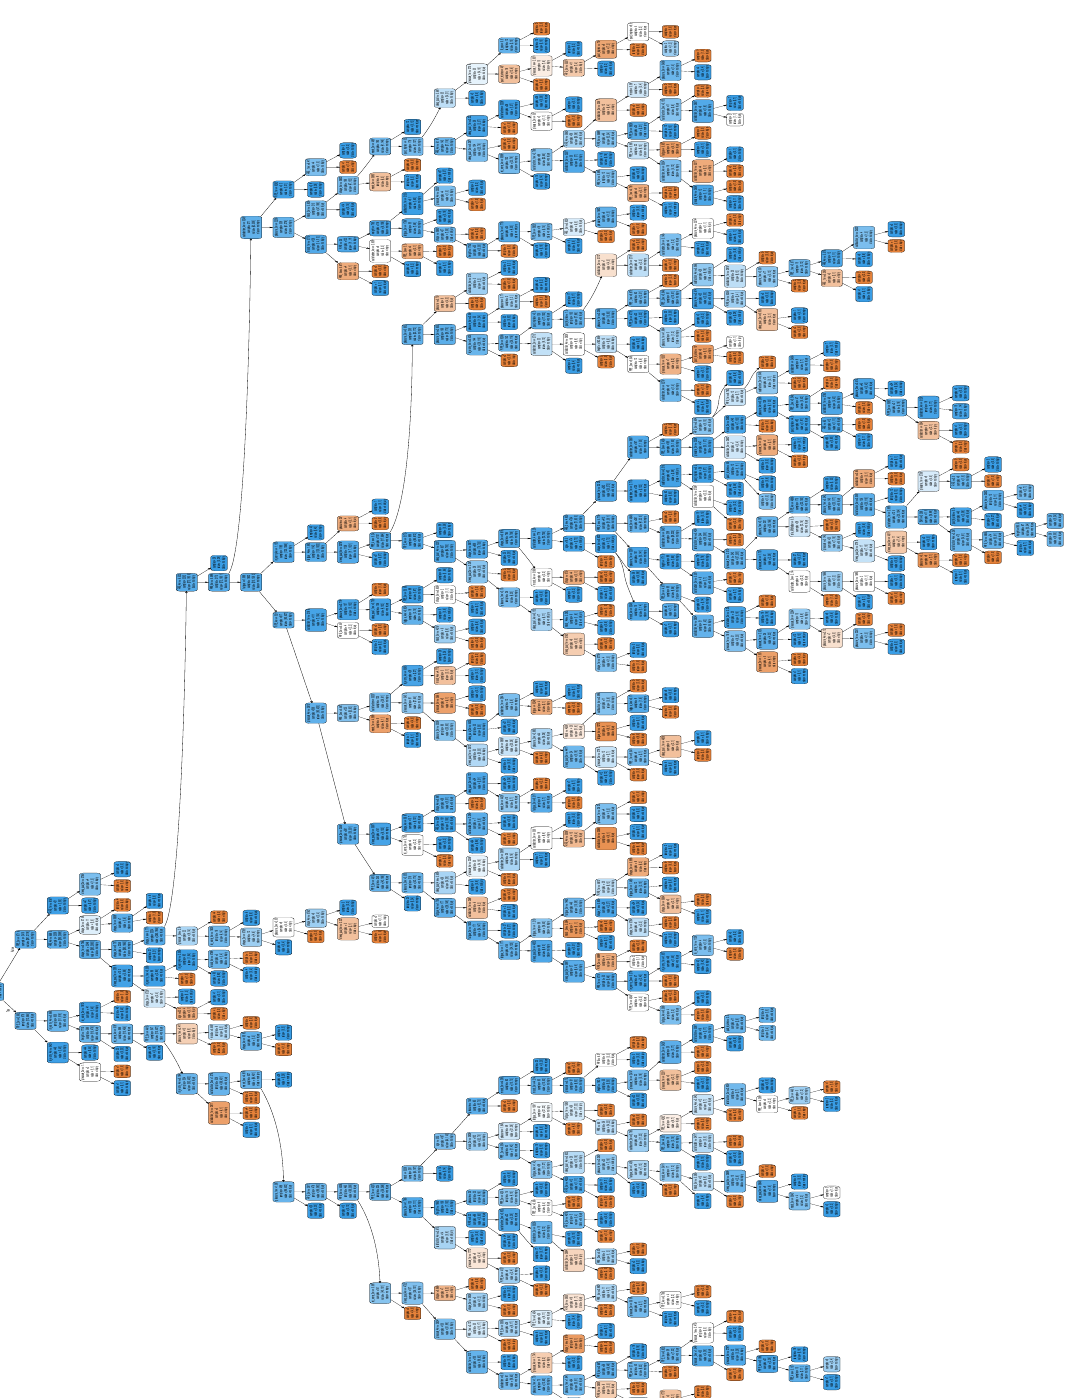
Figure A1. Complete decision tree learnt on questionnaires dataset for one-month injury prediction optimised for precision